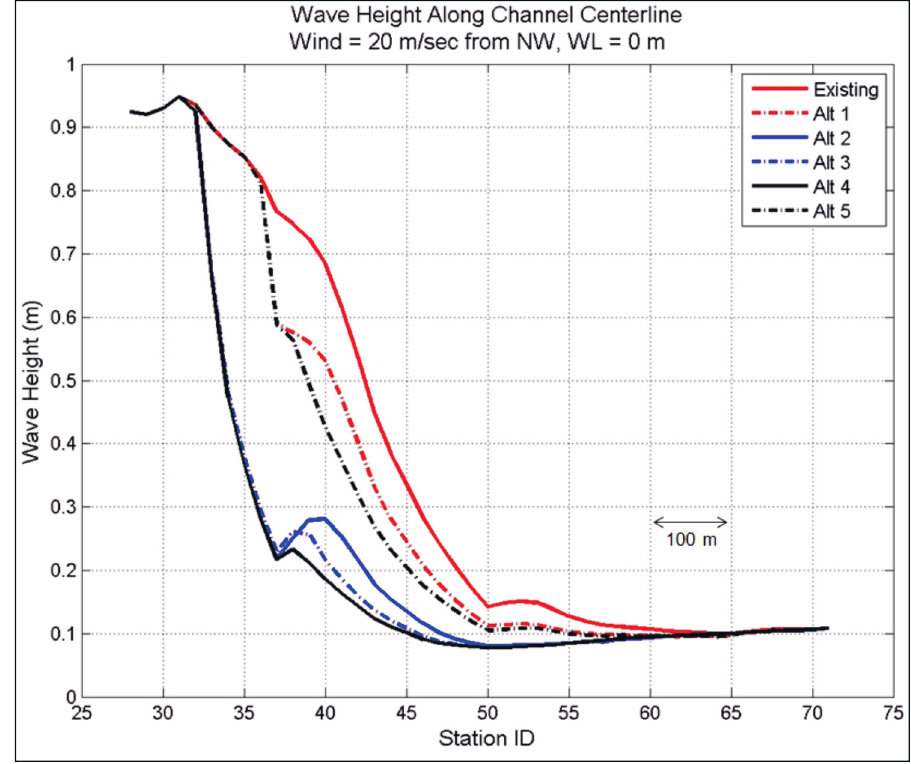
Figure 19. Model wave heights in the west channel for 50-year design wind from NW and WL = 0 m.